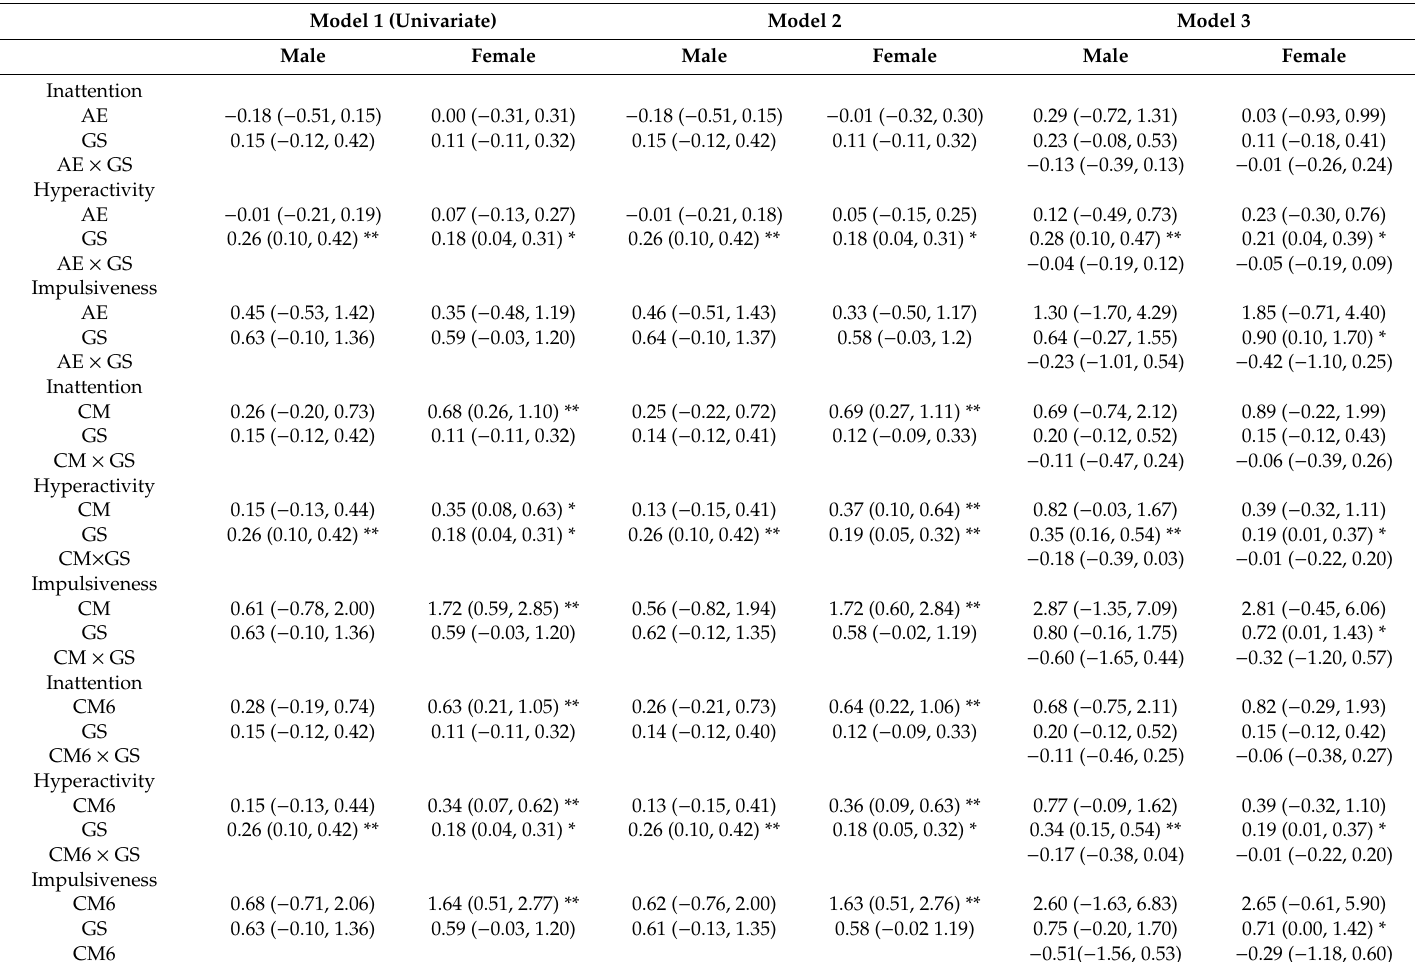
Table 4. Gender-stratified e ff ects of genetic, environmental (childhood adversity) and gene-environment interaction on the outcome